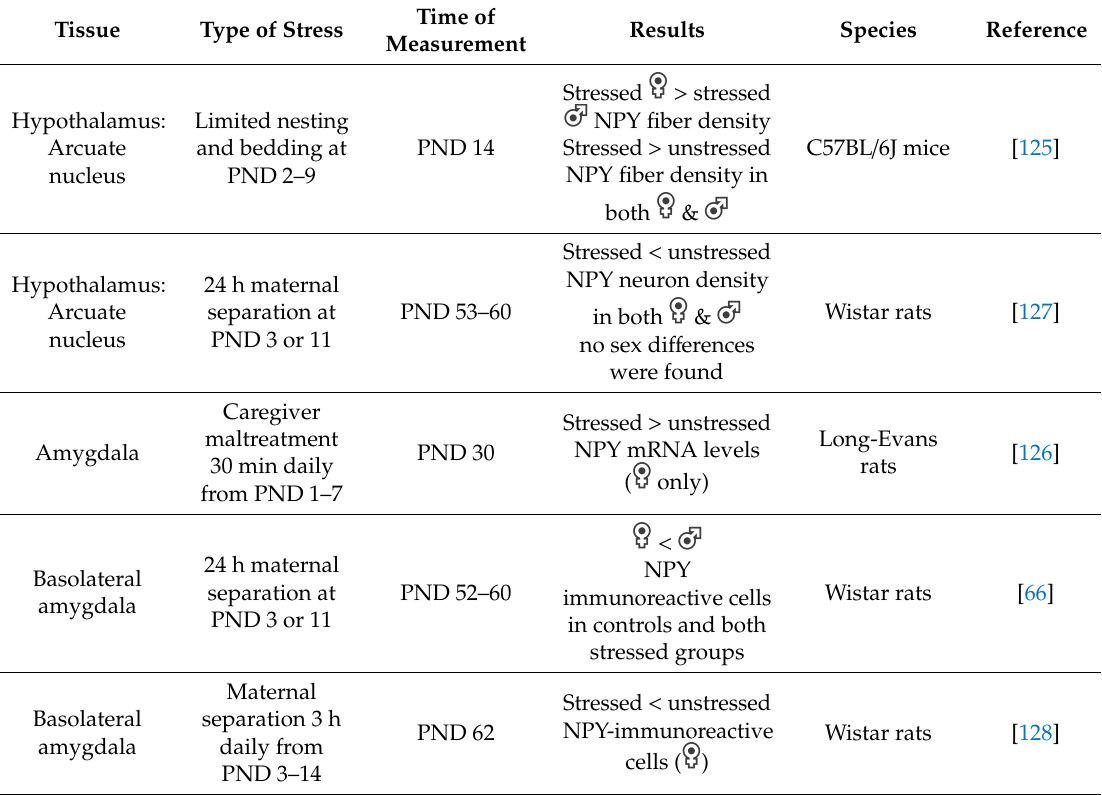
Table 2. Sex di ff erences in NPY expression levels after stress. Table 1. Sex differences in NPY expression levels in unstressed conditions. Table 1. Sex differences in NPY expression levels in unstressed conditions.